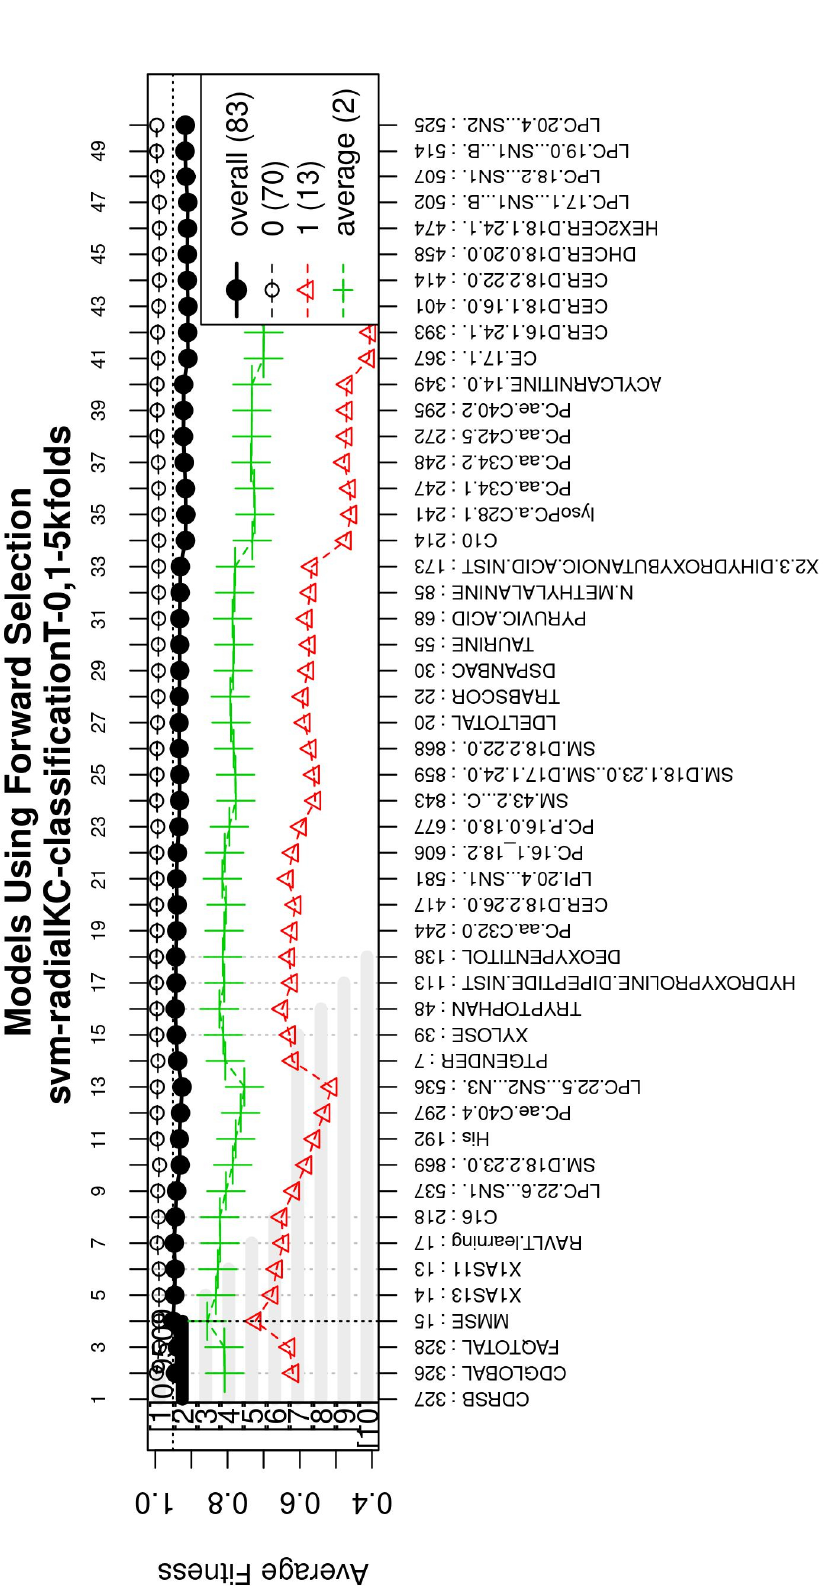
Figure A3. Performance of the most compact and accurate models after using the forward selection methodology. The horizontal axis represents the features ordered by rank. The vertical axis shows the classification